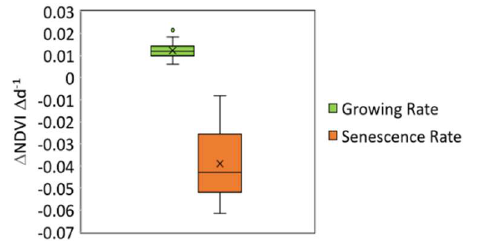
Figure 5 . GR and SR metrics for WW fields. Bottom-up: 5 th , 25 th , 50 th , 75 th and 95 th percentiles. Cross is the PM mean value. Dots are